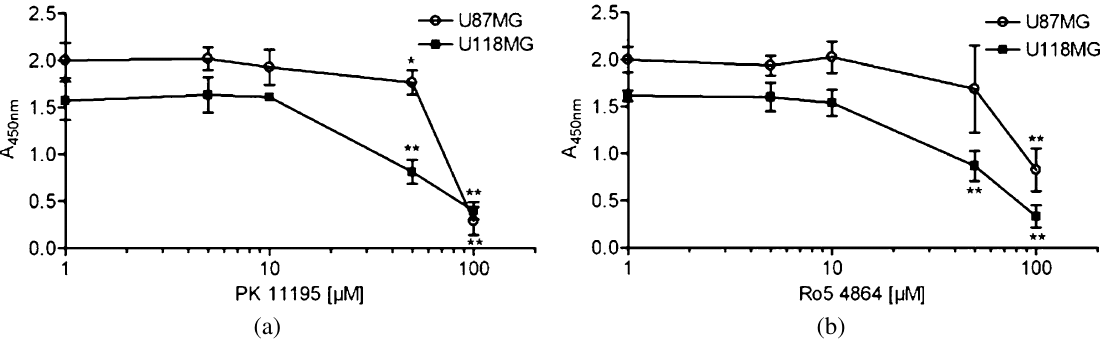
Fig. 3. Increasing concentrations of PK 11195 (a) and Ro5 4864 (b) were used to study the effects on proliferation of the cell lines U87MG and U118MG, assayed with BrdU incorporation. Absorption of 450 nm (A 450 nm ) indicates cell proliferation measured after 72 h of treatment. Symbols: ∗ p < 0 . 05 vs. vehicle control; ∗∗ p < 0 . 01 vs. vehicle